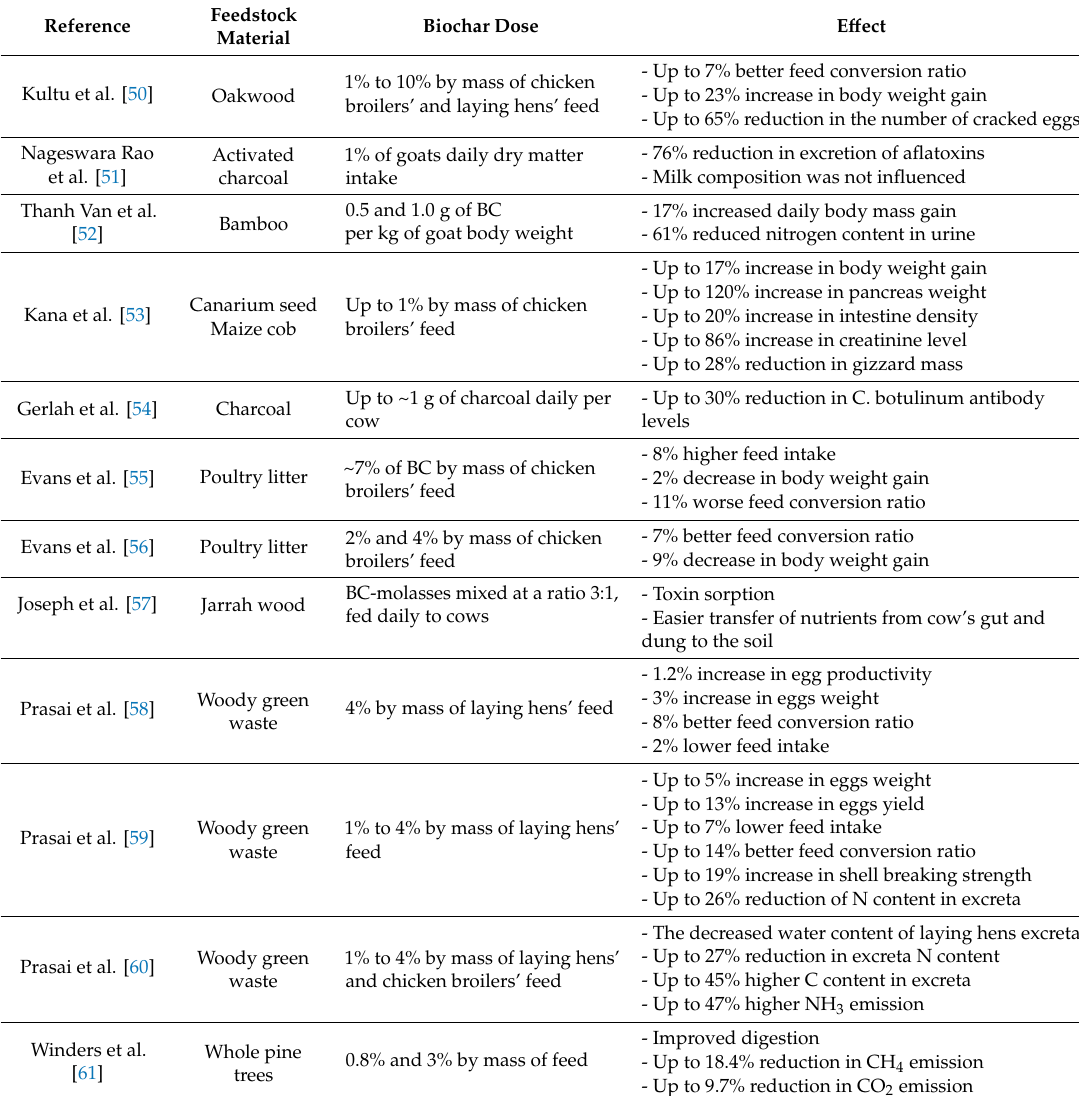
Table 4. Summary of selected data on biochar application to animal